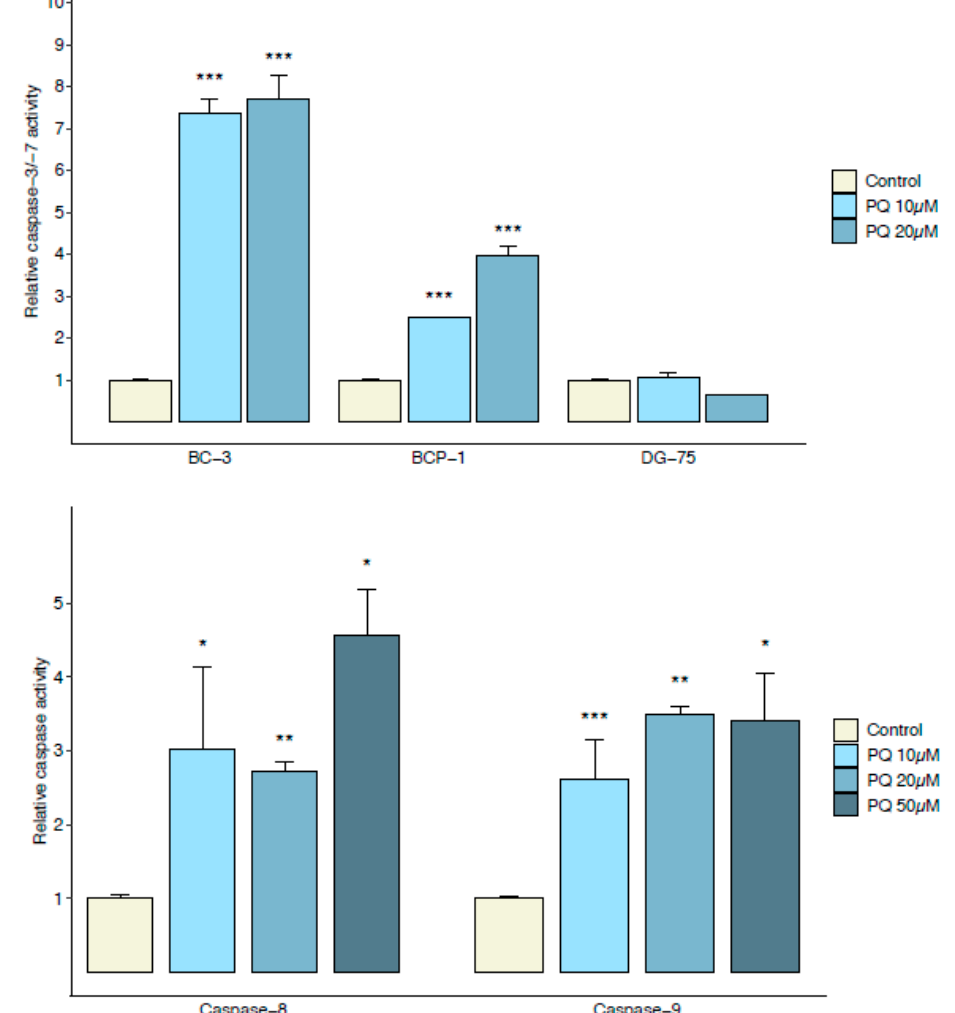
Figure 2. PQ induced caspase-dependent apoptosis in PEL cell lines. ( a ) Specific activation of the executioner caspase-3 and -7 in PQ-treated HHV-8-infected PEL cells. PEL cells (BC-3 and BCP-1) and HHV-8-uninfected Burkitt’s lymphoma cells (DG-75) were treated with PQ (10 and 20 µM) for 24 h followed by measurement of active caspase-3/-7 using the Caspase-Glo-3/-7 luminescent assay. Values